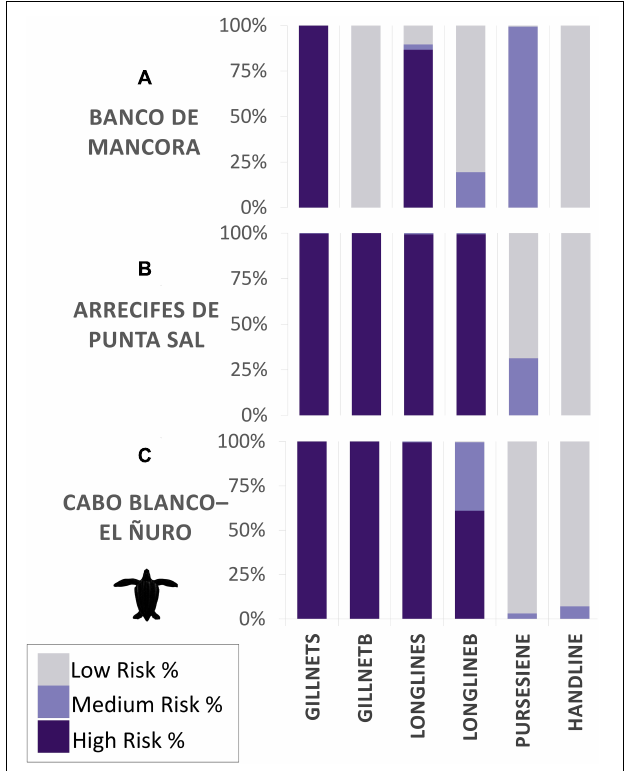
FIGURE 10 | Bycatch risk percentages calculated for leatherback turtles for each gear type. Subzones assessed are composed of proposed marine protected areas: (A) Banco de Mancora, (B) Arrecifes de Punta Sal, and (C) Cabo Blanco–El Ñuro, as part of the Grau Tropical Marine Reserve.